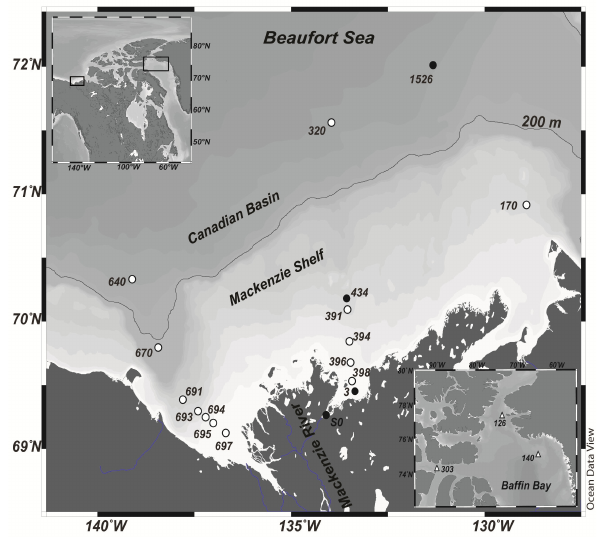
Fig. 1. Sampling map showing the Beaufort Sea (Mackenzie Shelf and Canadian Basin) in the western Canadian Arctic and Baffin Bay in the eastern Canadian Arctic. Filled circles denote CFL stations in June and July 2008, open circles signify Malina stations in August 2009, and open triangles represent SOLAS stations in September